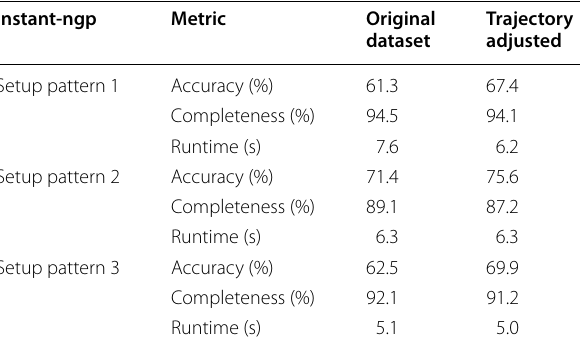
Table 6 Reconstruction performance comparison results of all three setup patterns by instant-ngp before and after removing the transition